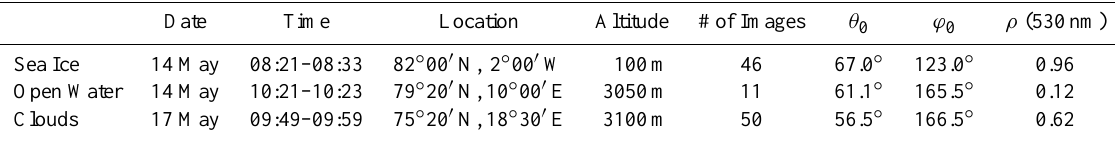
Table 1. HDRF measurements above sea ice, open water, and